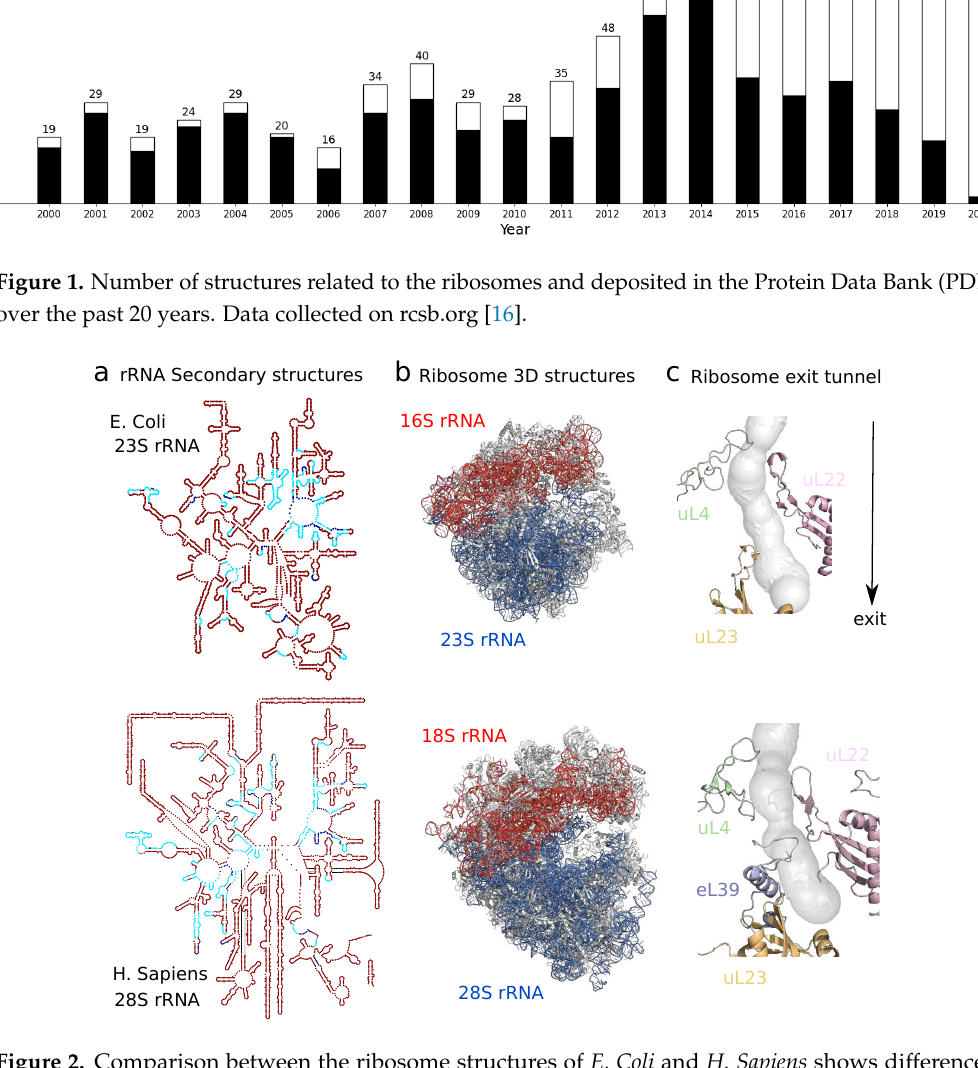
Figure 2. Comparison between the ribosome structures of E. Coli and H. Sapiens shows differences arising at different levels and scales. In contrast with prokaryotic 23S rRNA, constitutive of the large ribosomal subunit, eukaryotic 28S rRNA contains additional expansion segments inserted at specific positions in the common conserved rRNA core. Secondary structures are visualized in ( a ) using Ribovision [17], with conserved motifs in blue, following Doris et al. [18]. These differences, alongside variation in protein composition and sequence, affect the global 3D structure of the ribosome shown in ( b ). E. Coli and H. Sapiens cryoEM structures, visualized with Pymol, are taken from Fischer et al. [19] and Natchiar et al. [20]. The structural heterogeneity has a direct functional impact as shown in ( c ): At the ribosome exit tunnel through which the nascent polypeptide chain transits, the presence of eL39 at the exit or of an additional arm in uL4 which creates a second constriction site make the exit tunnel narrower and shorter in H. Sapiens